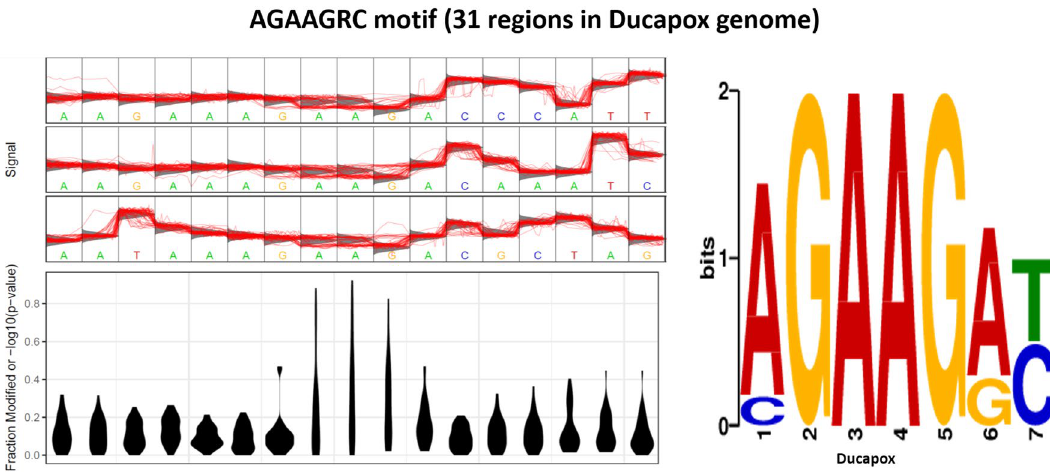
Figure 4. Statistical plot and sequence logo of the AGA AGR C motif. The statistical plot is based on 17 regions within the genome that contain the motif sequence. Signal fluctuation away from the canonical model can be seen around the central AAG nucleotides.